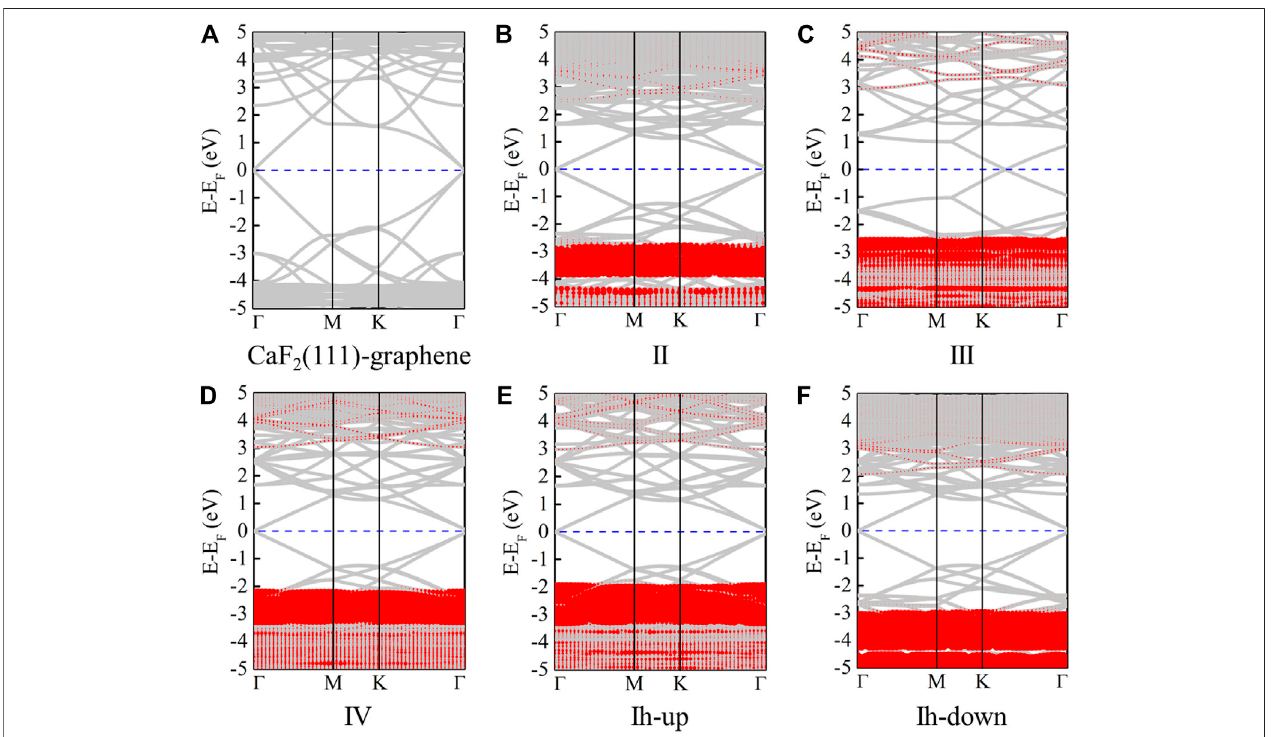
FIGURE 3 | Band structures of CaF 2 (111)/graphene (A) , CaF 2 (111)/II/graphene (B) , CaF 2 (111)/III/graphene (C) , CaF 2 (111)/IV/graphene (D) , CaF 2 (111)/Ih-up/ graphene (E) ,andCaF